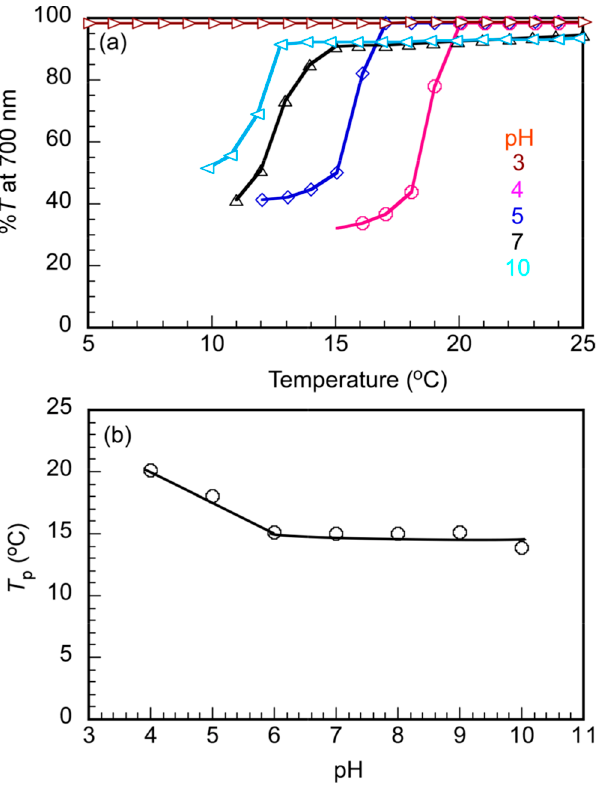
Figure 7. ( a ) Percent transmittance (% T ) at 700 nm for the P(VS) 17 A 50 /PAAc 49 PIC vesicle aqueous solution with f + = 0.5 as a function of temperature upon the cooling process at different pH at C p = 0.1 g/L, and ( b ) pH dependence of the phase transition temperature ( T p ) for the PIC vesicle aqueous solution with f + = 0.5 at C p = 0.1 g/L.